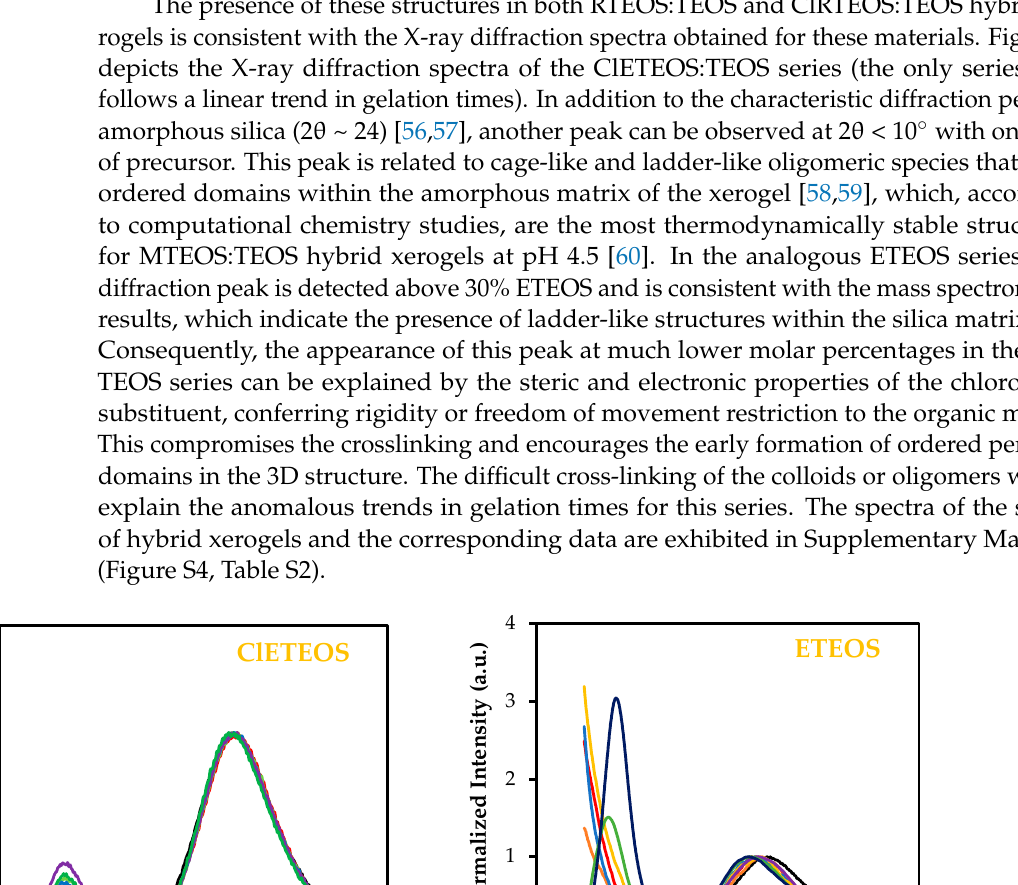
( c ) Figure 5. Normalized FTIR spectra of the 1300–980 cm − 1 region of the TEOS xerogel (black), and those of the three chloro- alkyl series at different molar ratios: ( a ) 5%, ( b ) 10%, and ( c ) 20%. (ClMTEOS (red), ClETEOS (yellow), and ClPTEOS (blue)).